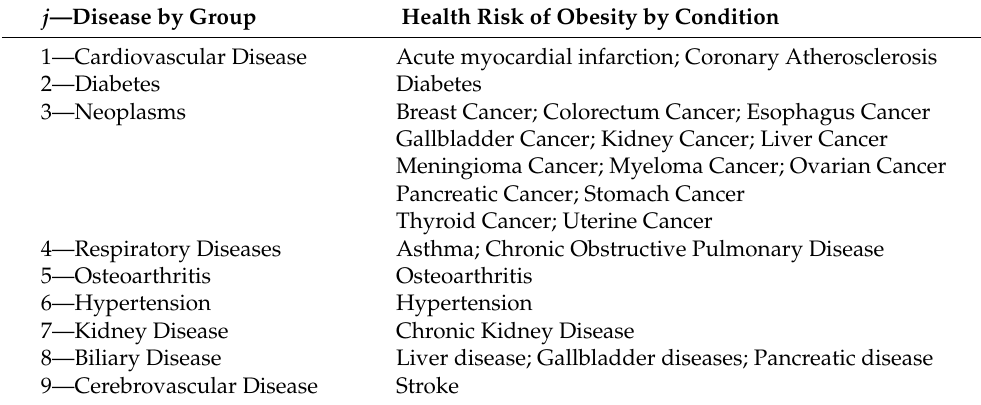
Table 1. Summary of the obesity related health risks linked to the corresponding disease in group j . Source: Centers for Disease Control and Prevention, Consequences of Obesity